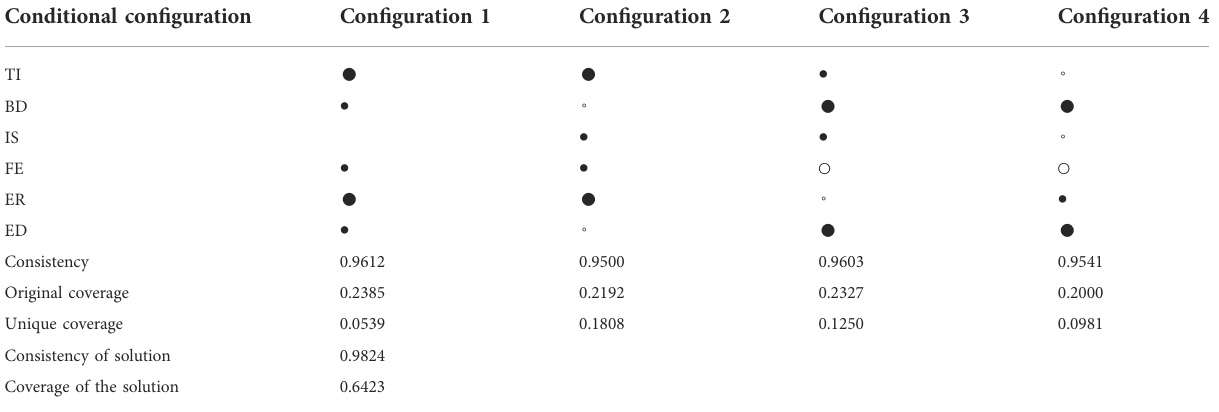
TABLE 5 Analysis of high-level circular economy performance con fi guration in eastern